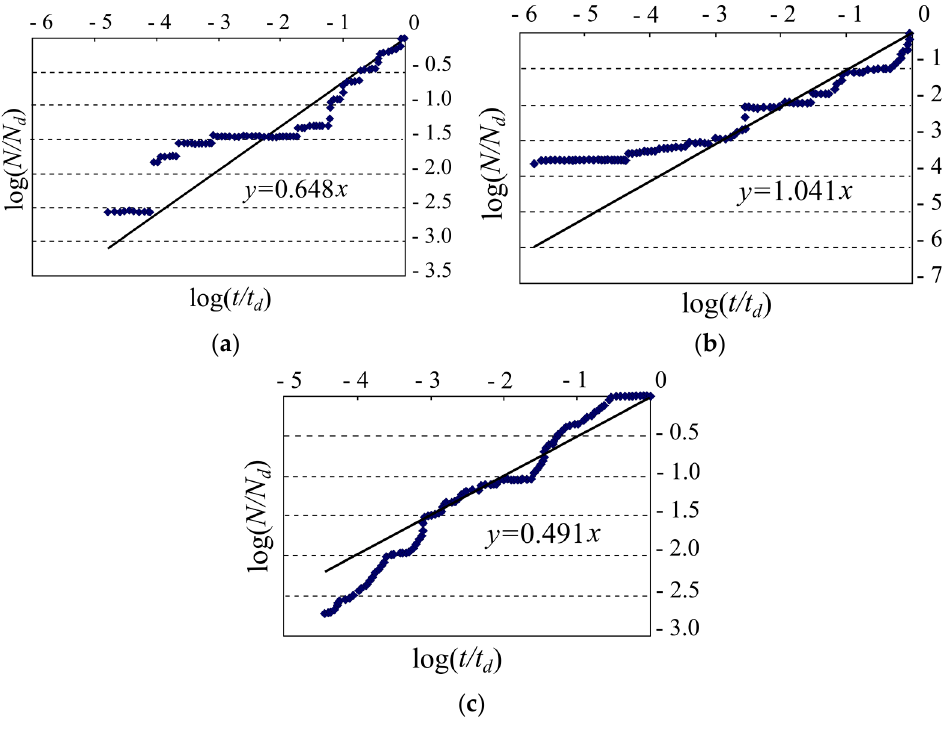
Figure 5. Damage monitoring: ( a ) Sineo tower; ( b ) Astesiano tower; ( c ) Bonino tower.